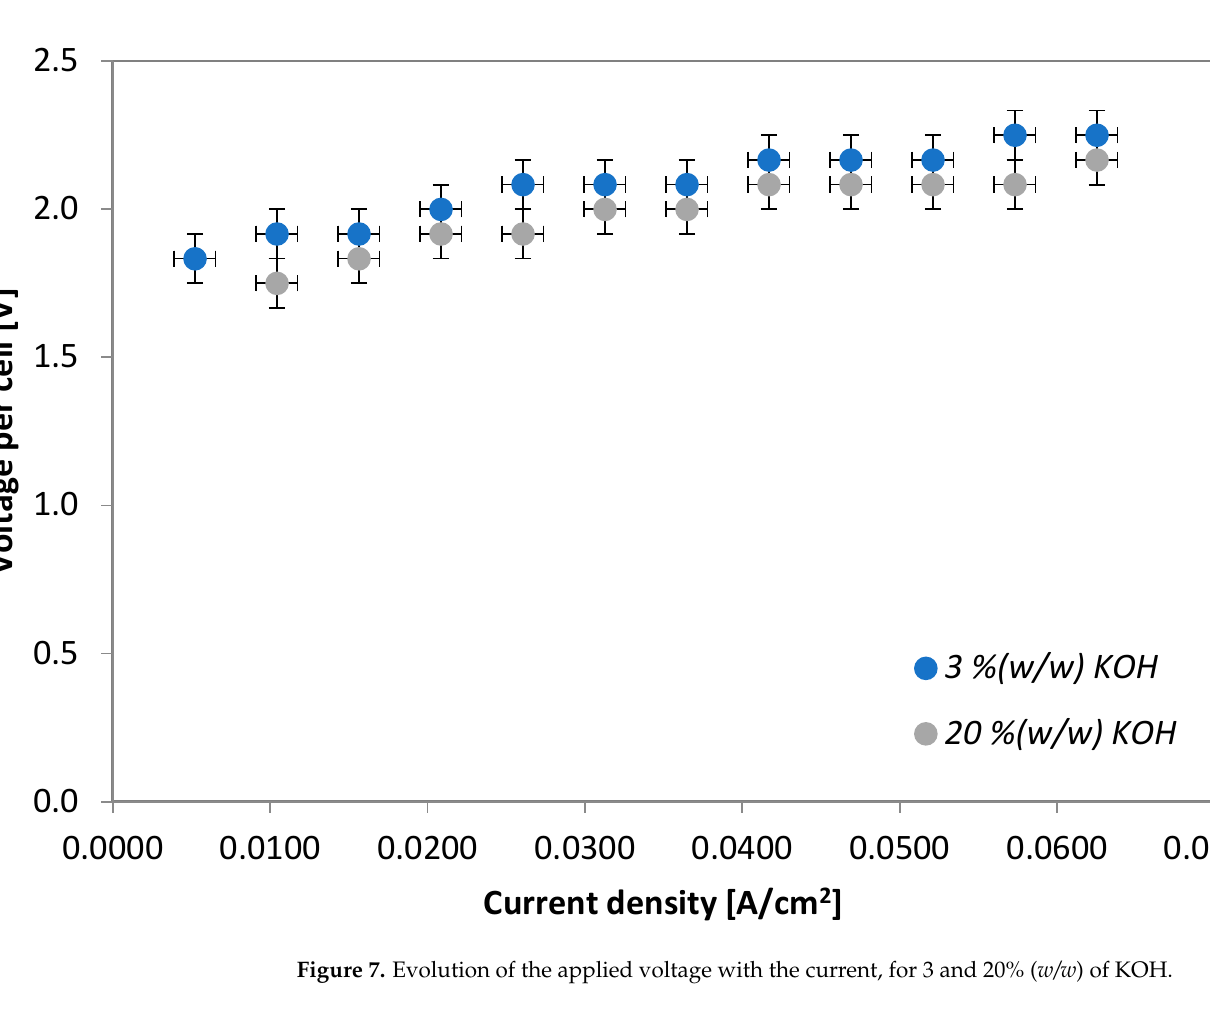
Results are presented in Tables 8 and 9 and the representation of efficiency as a function of the input power is displayed in Figure